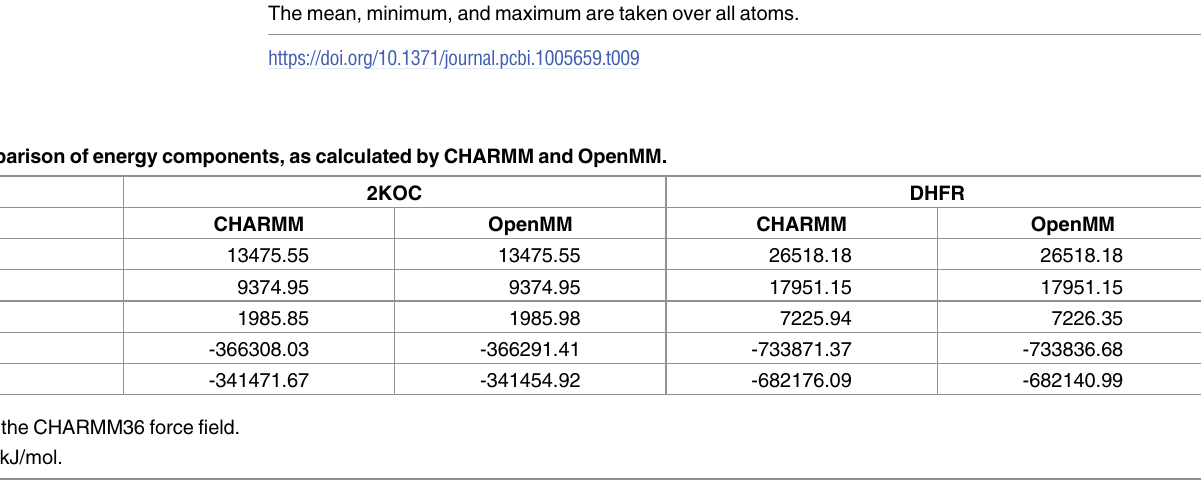
Values are the normalized projection of the Gromacs forces ( F G ) onto the OpenMM forces ( F O ): ( F G (cid:1) F O )/ ( F O (cid:1) F O ). The mean, minimum, and maximum are taken over all atoms.